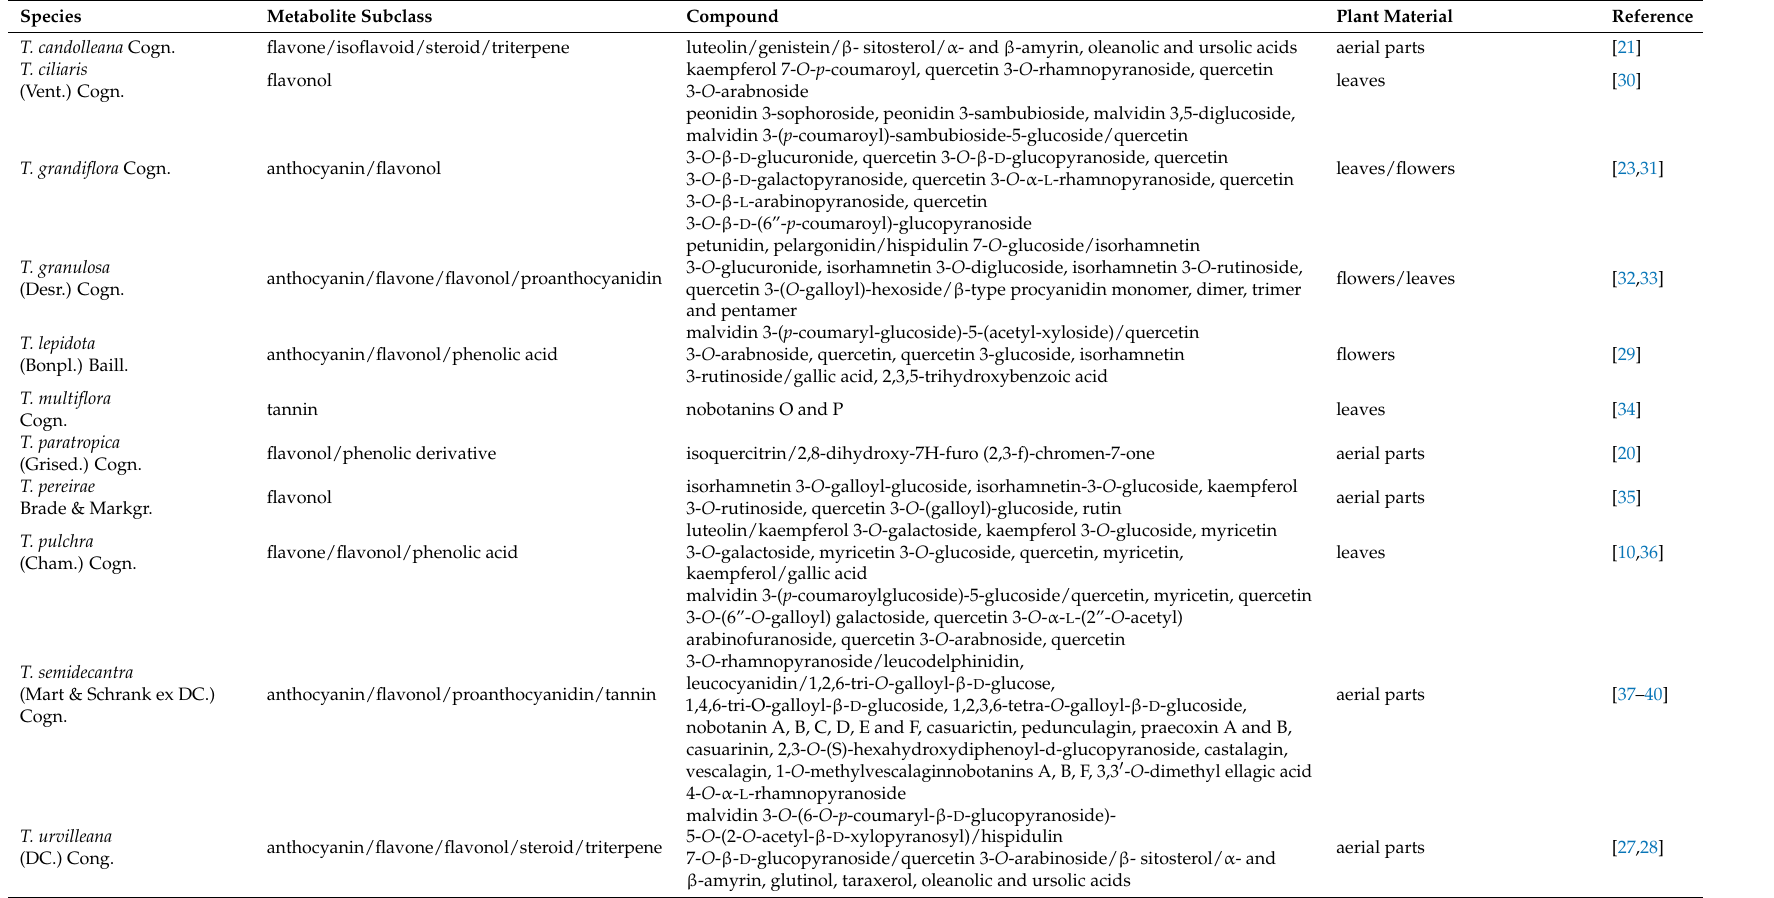
Table 1. Natural products reported for Tibouchina